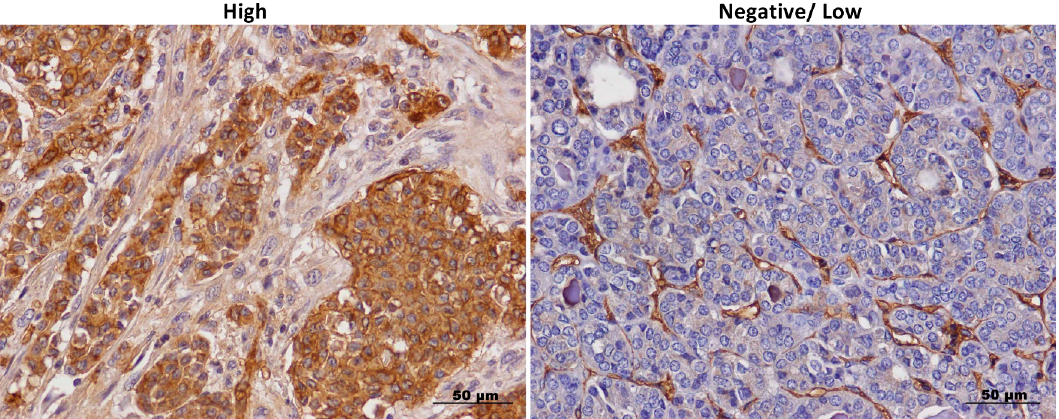
Figure 1. Anexeleto (AXL) staining in thyroid cancer samples. Representative images of high and low/negative AXL immunohistochemical staining in thyroid cancer samples at 40× magnification, scale bar = 50 μ m. High and negative/low staining was defined as described in the Section “Materials and Methods”.